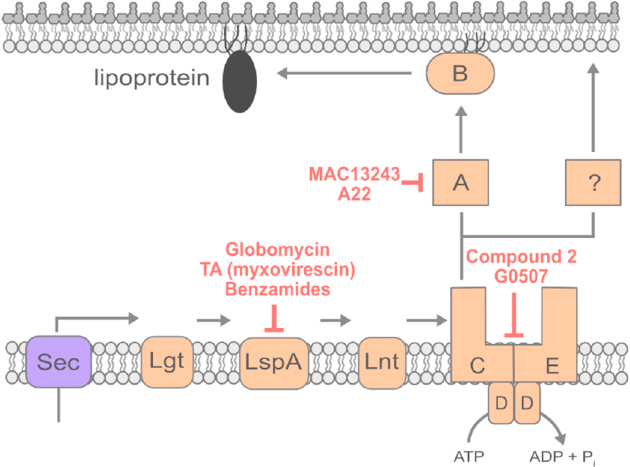
Figure 3. Lipoprotein trafficking and its inhibitors. Lipoproteins are synthesized in the cytoplasm and secreted by SecYEG. In the IM, lipoproteins undergo a series of modifications by Lgt, LspA, and Lnt to become mature triacylated species. The ATP-binding cassette (ABC) transporter LolCDE then extracts mature lipoproteins from the IM. LolA receives lipoproteins from LolC and traffics lipoproteins across the periplasm to the OM. At the OM, LolB receives and inserts lipoproteins. Recent work has indicated that an alternate route of lipoprotein trafficking must exist that does not require LolA or LolB. Red labels indicate compounds targeting lipoprotein maturation and trafficking. Lol: localization of lipoproteins.